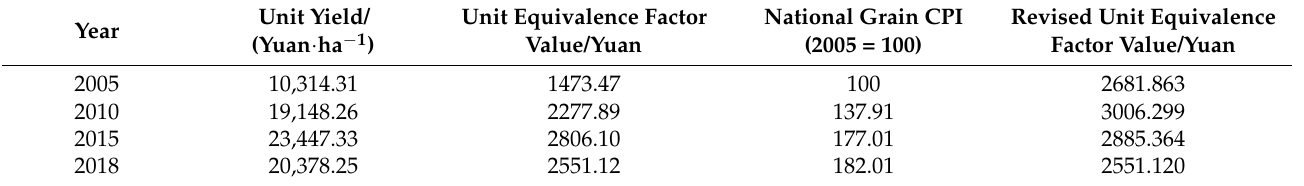
Abbreviations: CPI: Consumer Price